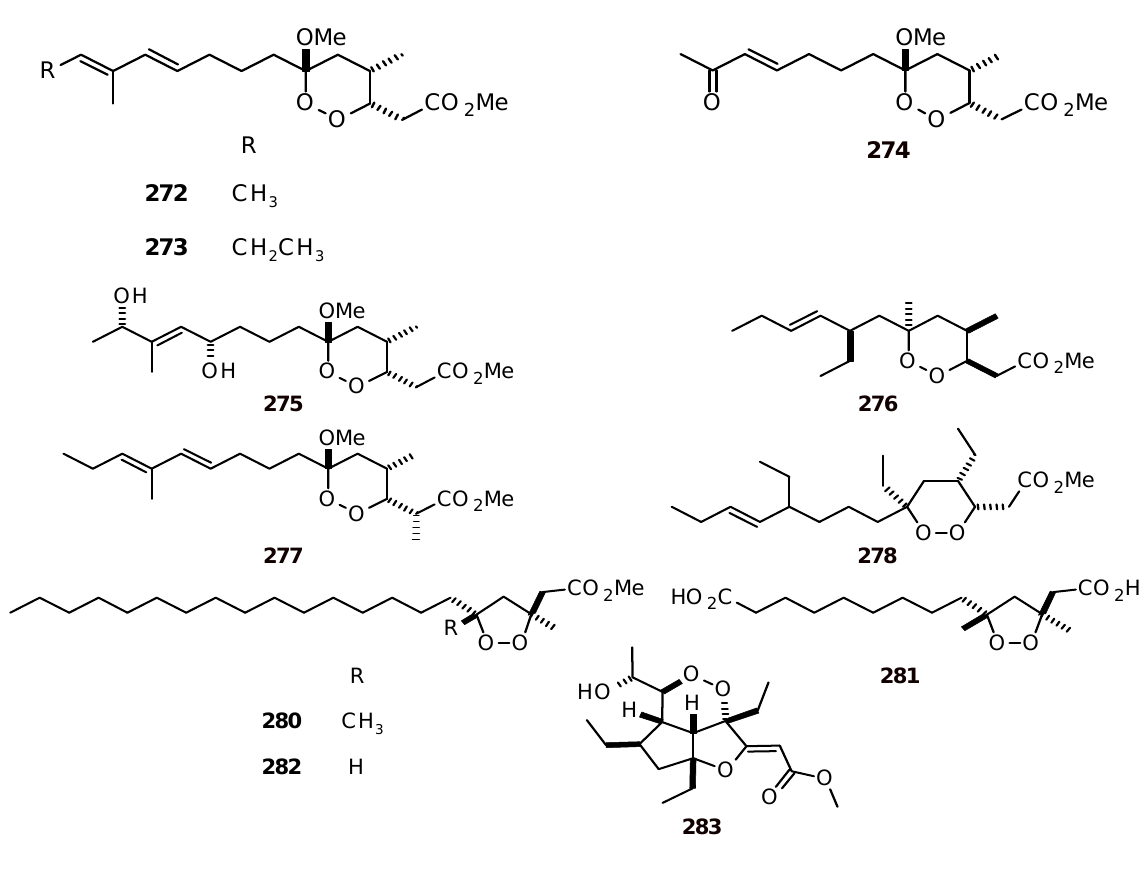
Figure 34. Structures of peroxide polyketides 272-278 and 280-282 .